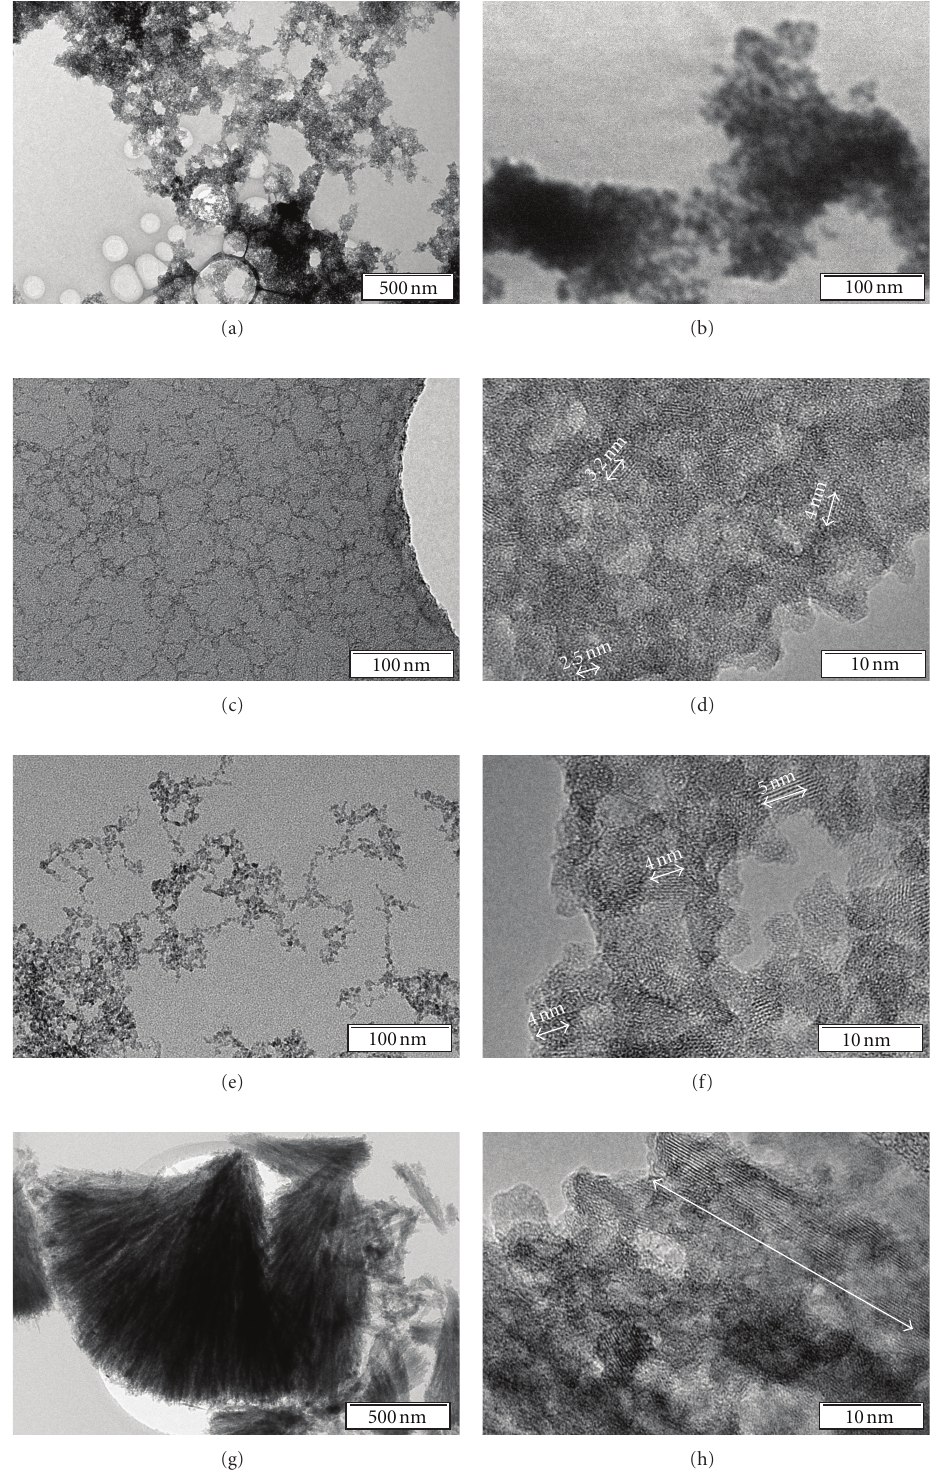
Figure 8: HR-TEM micrograph of nanoscale titanium dioxide samples of di ff erent structure: amorphous (a, b), brookite (c, d), anatase (e, f), and rutile (g, h). Arrows indicate planes of the aggregate formed by spliced particles. The needle crystals consist of coherently spliced crystallites having the size of 5-6 nm along plane (100) and 4-5nm along plane